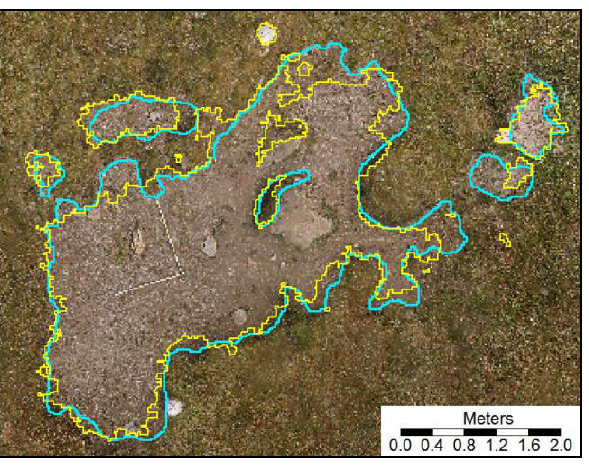
Figure 4: Classification results (eroded area boundaries) for scene 10 (yellow) and the manual classification (blue).